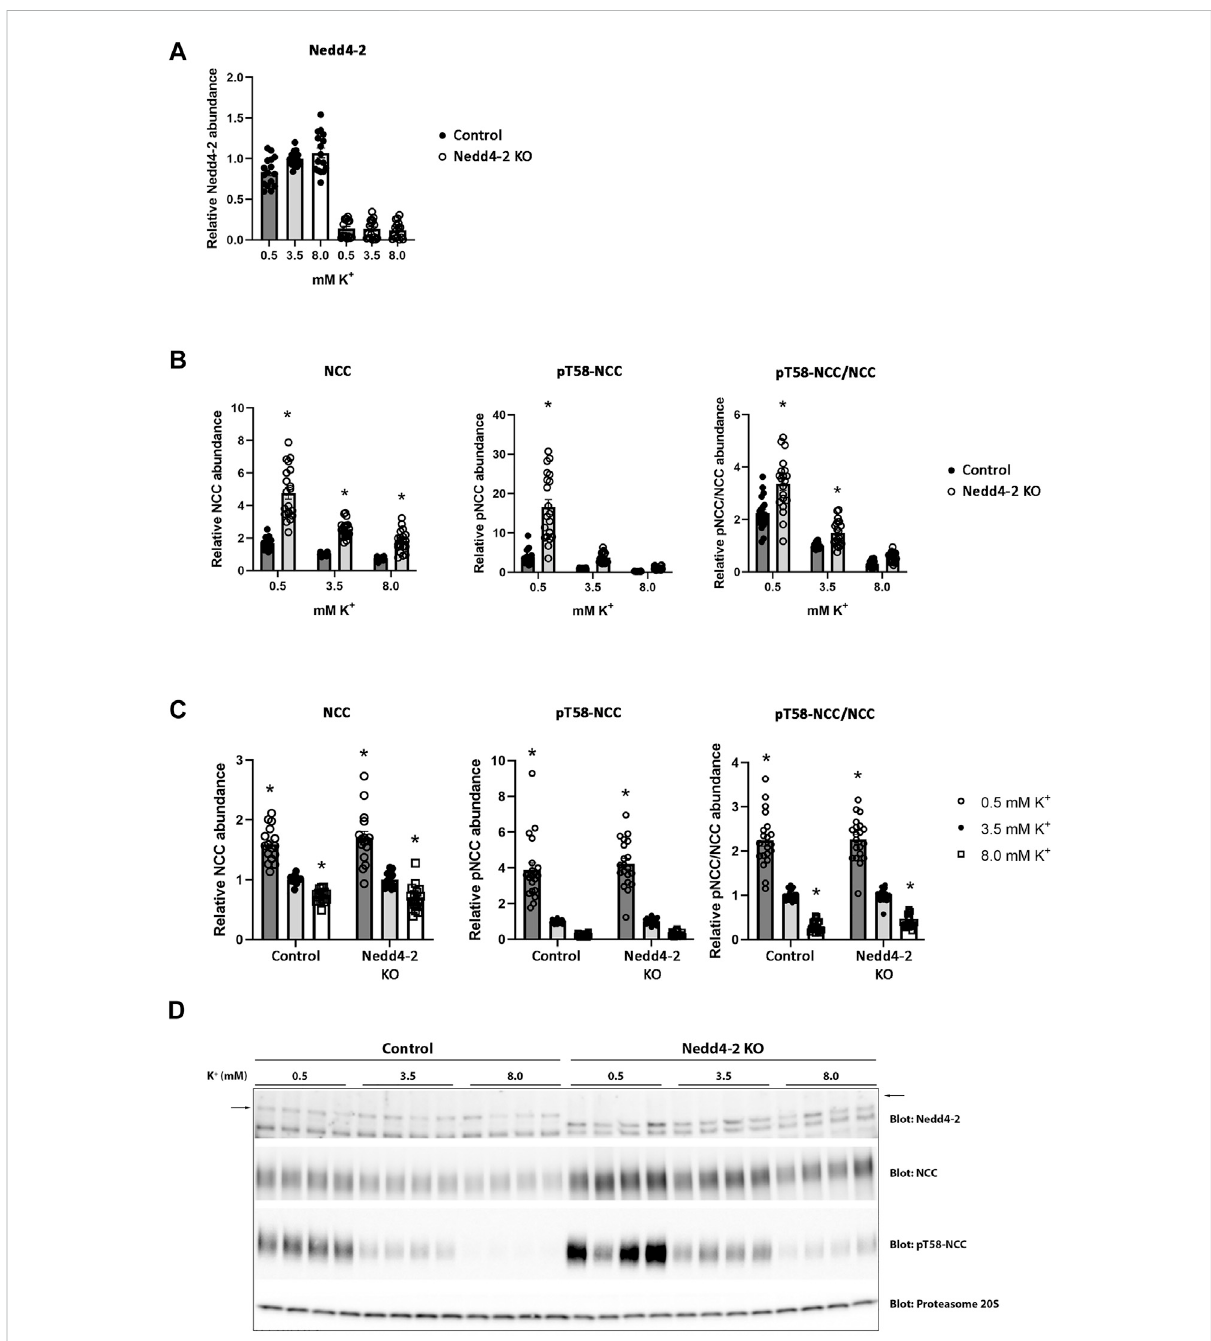
FIGURE 8 Nedd4-2 is not involved in the potassium induced regulation of NCC and pT58-NCC. Semi-quantitative assessment of Nedd4-2 (A) , NCC, pT58-NCC,andpT58-NCC/NCC (B+C) levelsintubulesisolatedfromcontrolandNedd4-2KOmiceandtreatedwith0.5mM,3.5mM,or8.0 mMK + for24 h. (A+B) Dataaremeans±S.E.Mandnormalizedtocontroltubulestreatedwith3.5 mMK + .DifferencebetweencontrolandKOtubulestreated with either 0.5 mM, 3.5 mM, or 8.0 mM K + is assessed by 2way ANOVA followed by Tukey ’ s multiple comparisons test (* p < 0.05). (C) Data are means ± S.E.M. Control and KO tubules are normalized to their own 3.5 mM K + group. Differences of NCC and pT58-NCC levels with different K + concentrationsineithercontrolorKOtubulesareassessedby2wayANOVAfollowedbyTukey ’ smultiplecomparisonstest(* p < 0.05).Foldchanges between control and KO tubules with changing K + concentrations are assessed in the same 2way ANOVA analysis (n = 16 – 20). (D) Representative immunoblots of Nedd4-2, NCC, pT58-NCC, and proteasome 20S in control and KO tubules treated with 0.5 mM, 3.5 mM, or 8.0 mM K +